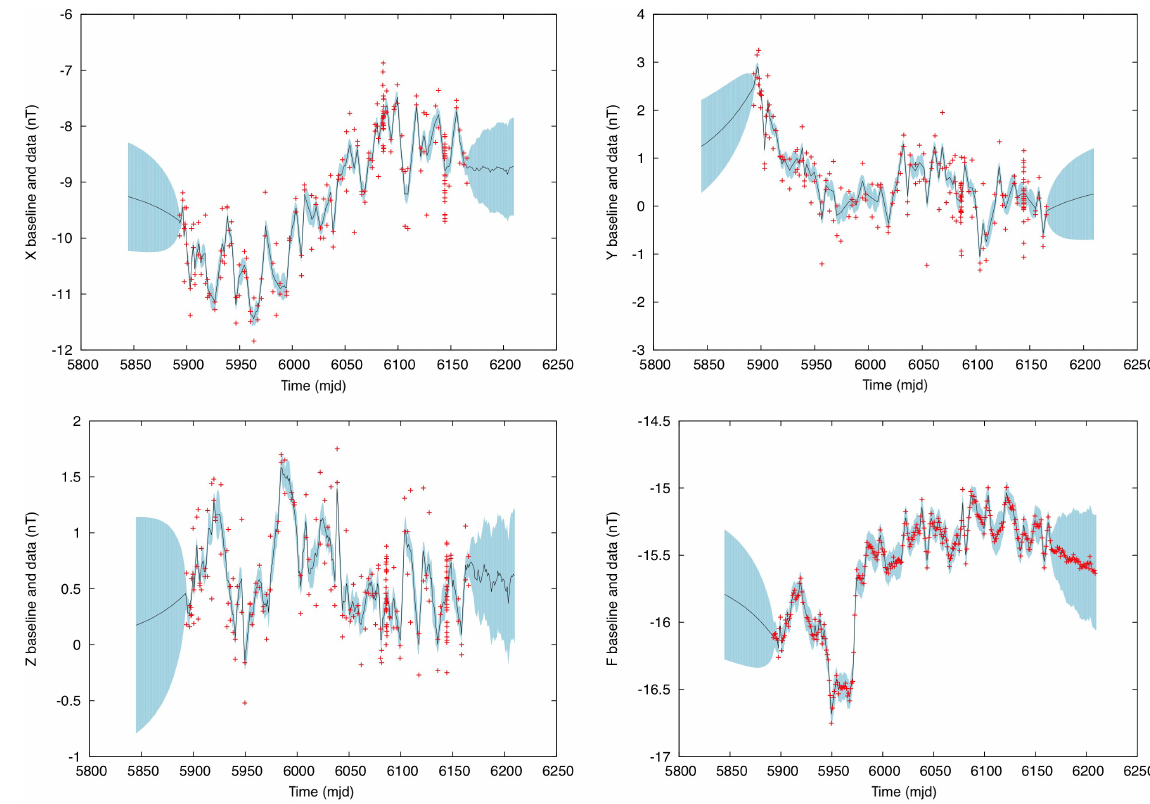
Figure 4. Estimated baseline values in black for the X , Y , Z components and F values. The 1 σ interval is shown in light blue. Differences between absolute and variation data are shown in red. Series 1 and Series 2 were made during mjd = 6086 and mjd = 6144